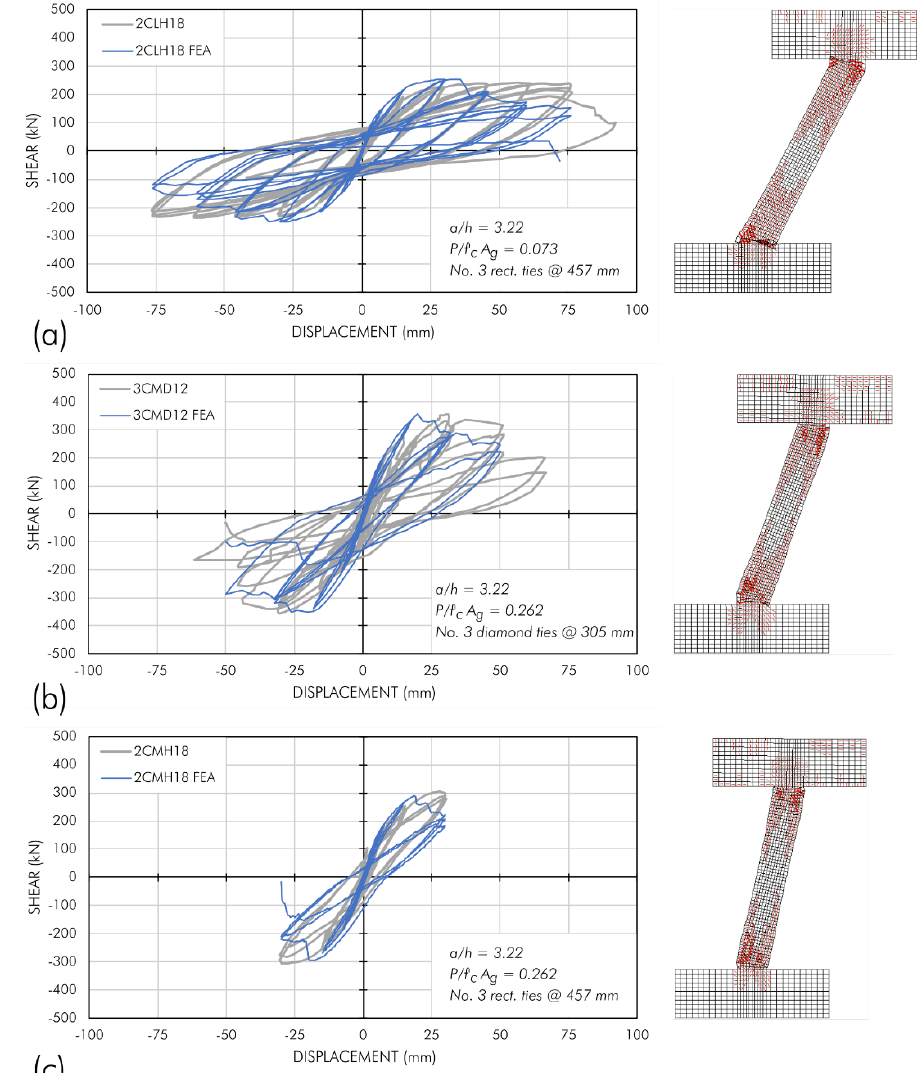
Figure 11. Nonlinear finite element analysis predictions of shear-deflection responses and deflected shapes at failure (20× magnification) for columns tested by Lynn et al. [15]: ( a ) 2CLH18; ( b ) 3CMD12; ( c ) 2CMH18.